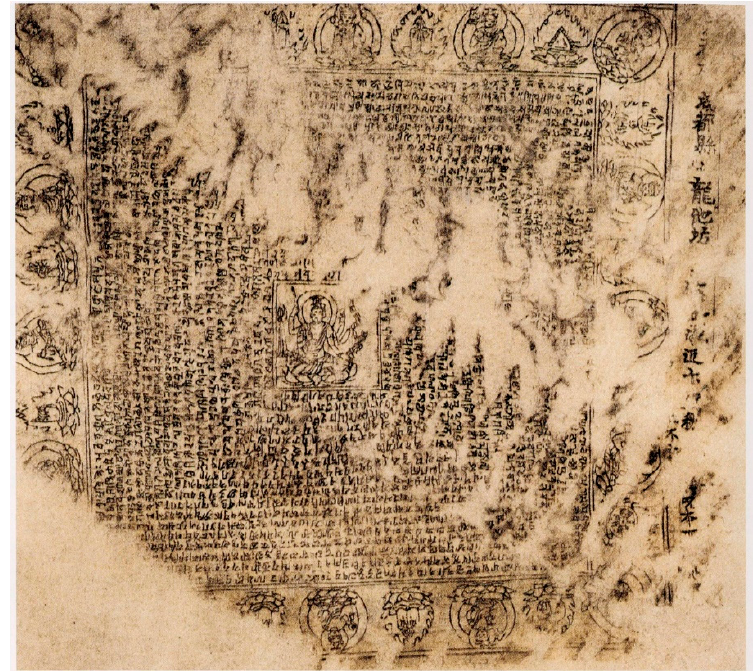
Figure 2. Pratisara Dharani (Ch. Suiqui tuoluoni ), Tang (presumed around 8th century), 31.0 × 24.0 cm, National Library of China. Source: (Li 2008, Figure 4).